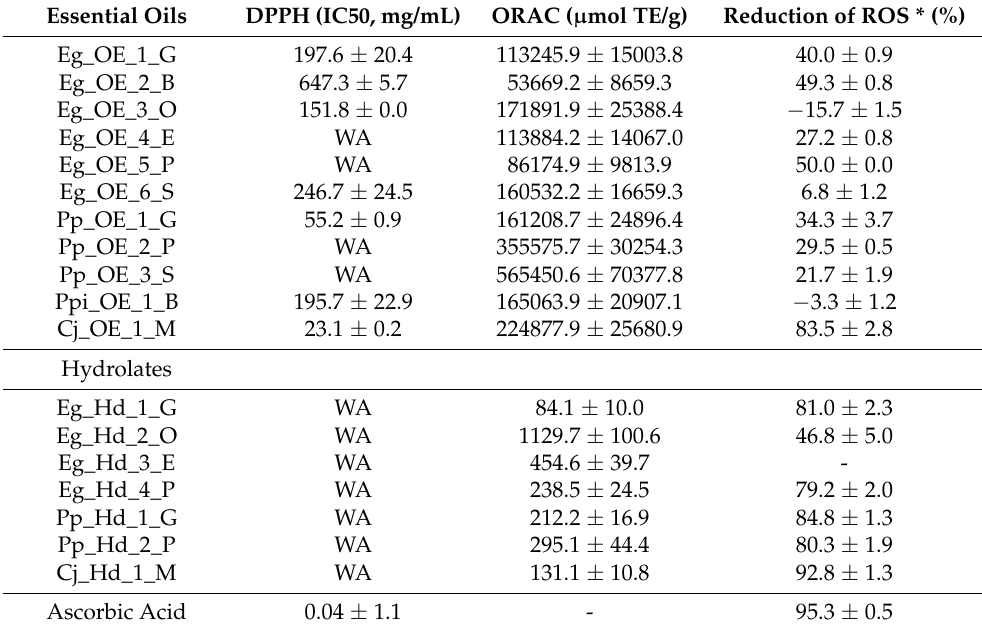
Table 3. Antioxidant capacity of the assessed essential oils and hydrolates. For samples codes vide Materials and Methods